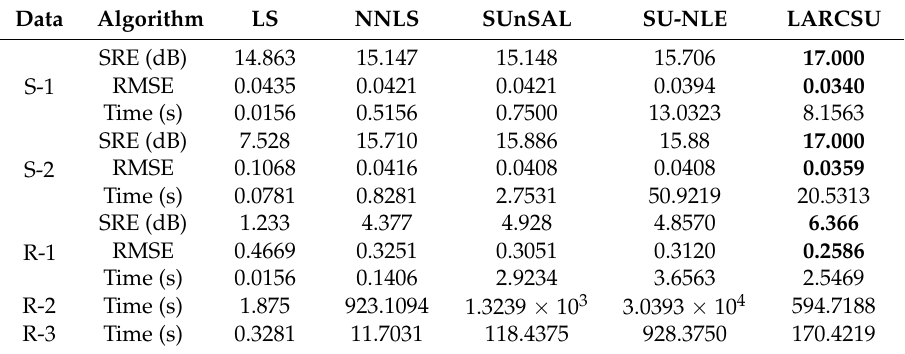
Table 1. Performance comparison for the different methods with the five